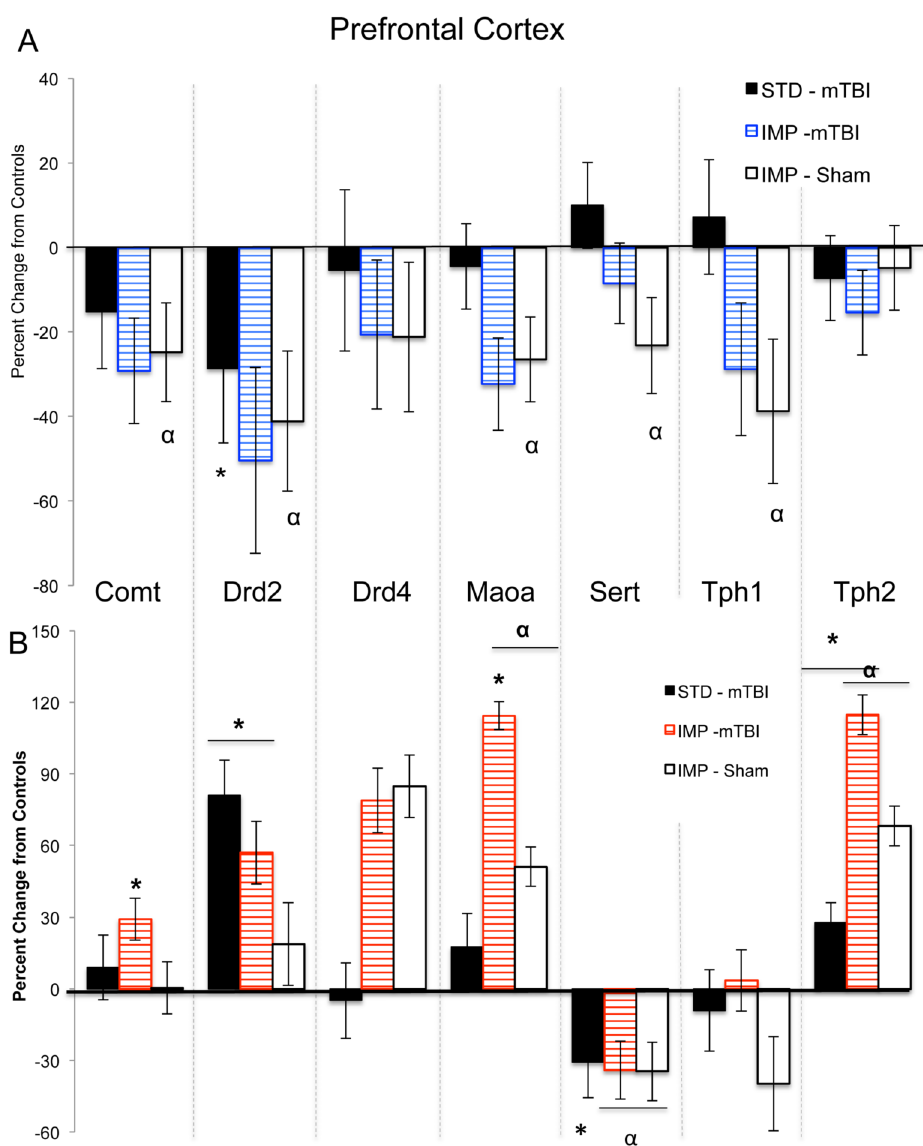
Fig 10. Changes in NAc gene expression for STD animals with a mTBI and IMP animals from both groups. Males are in the upper panel (A) and females in the lower panel (B). The centerline of each graph represents typical expression (STD-shams) with the bars exhibiting percent changes from normal ( * effect of mTBI, α effect of cohort, p < .05).